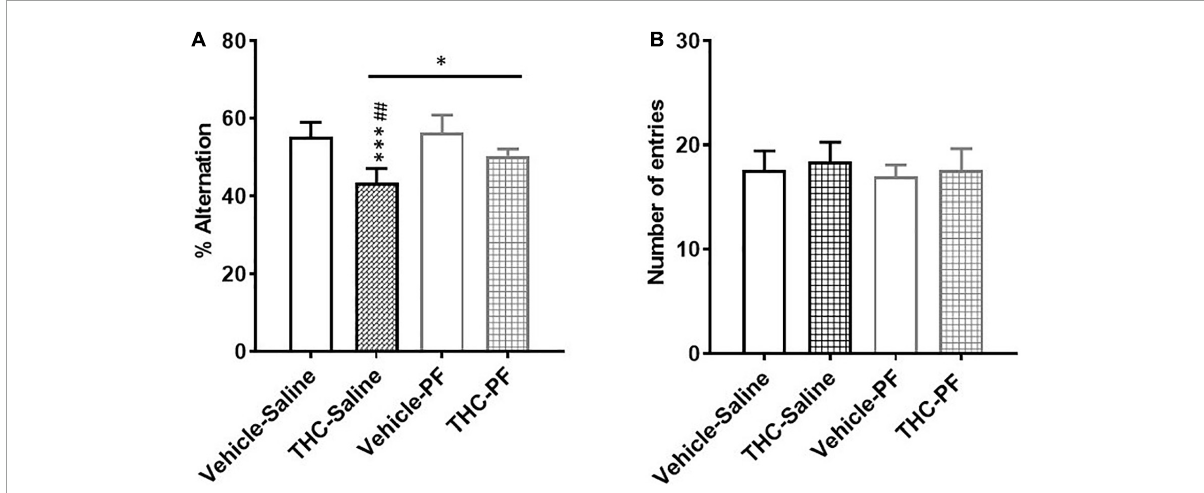
FIGURE6 Y-maze test showing the percentage of spontaneous alternations (A) and the number of arm entries (B) in adult rats [post-natal day (PND) 75] chronically exposed to delta 9-tetrahydrocannabinol (THC) or its vehicle (cremophor and saline 1:1:18; Vehicle) during the adolescent period. Ascending doses of THC or its vehicle were administered by i.p. to adolescent rats, from PD 35 to PD 45. Bars represent the mean ± standard error of the mean (SEM; n = 5/6 male rats/group). Data were analyzed by two-way ANOVA and subsequent Tukey’s post hoc test for multiple